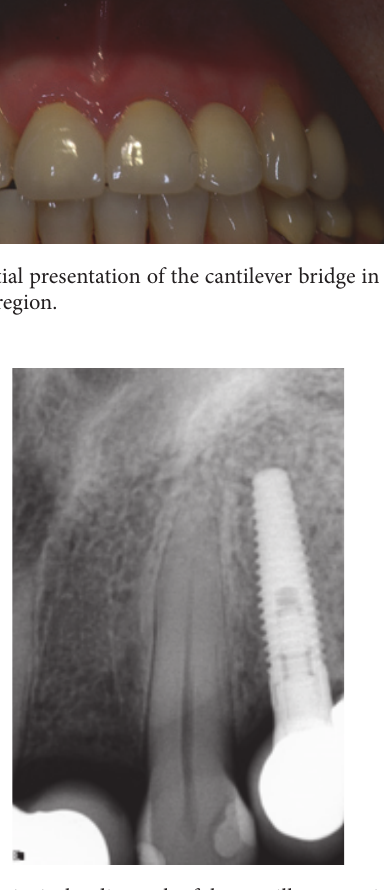
Figure 2: Periapical radiograph of the maxillary anterior region.